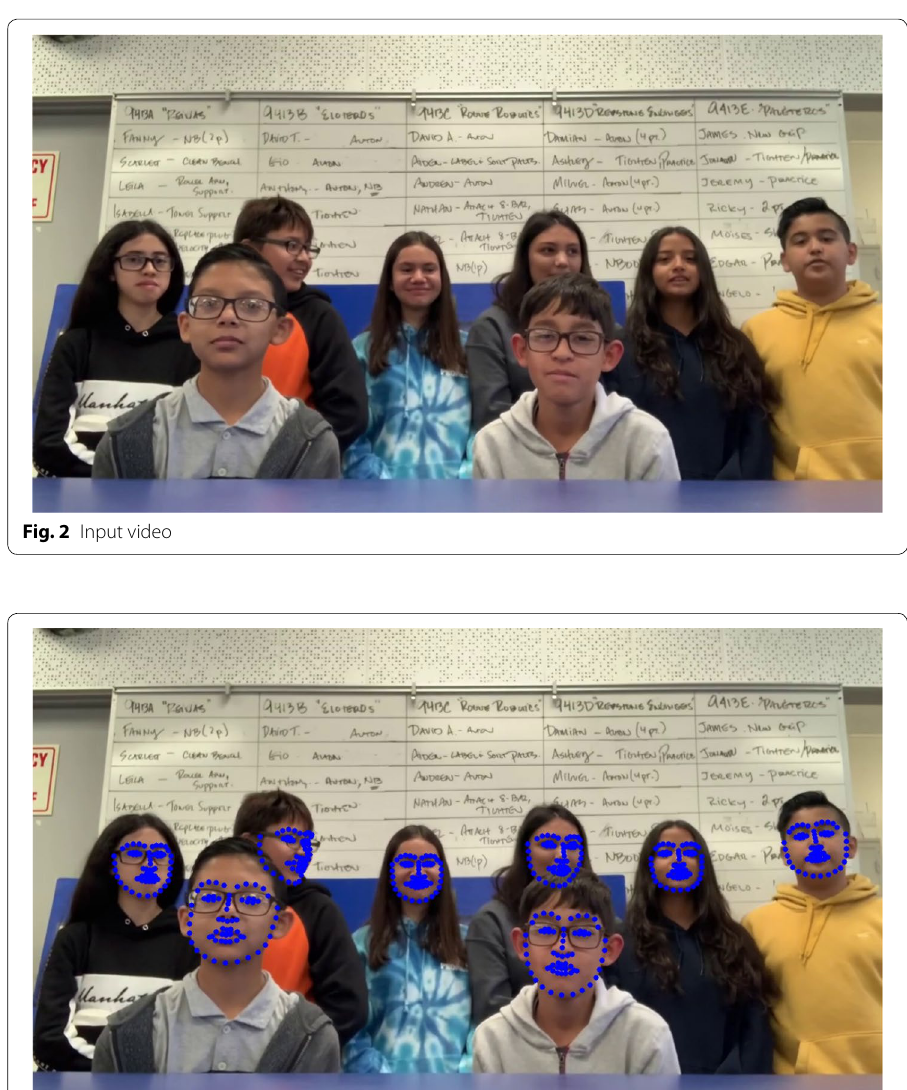
Fig. 3 Face detection by Voila and Jones and eye center